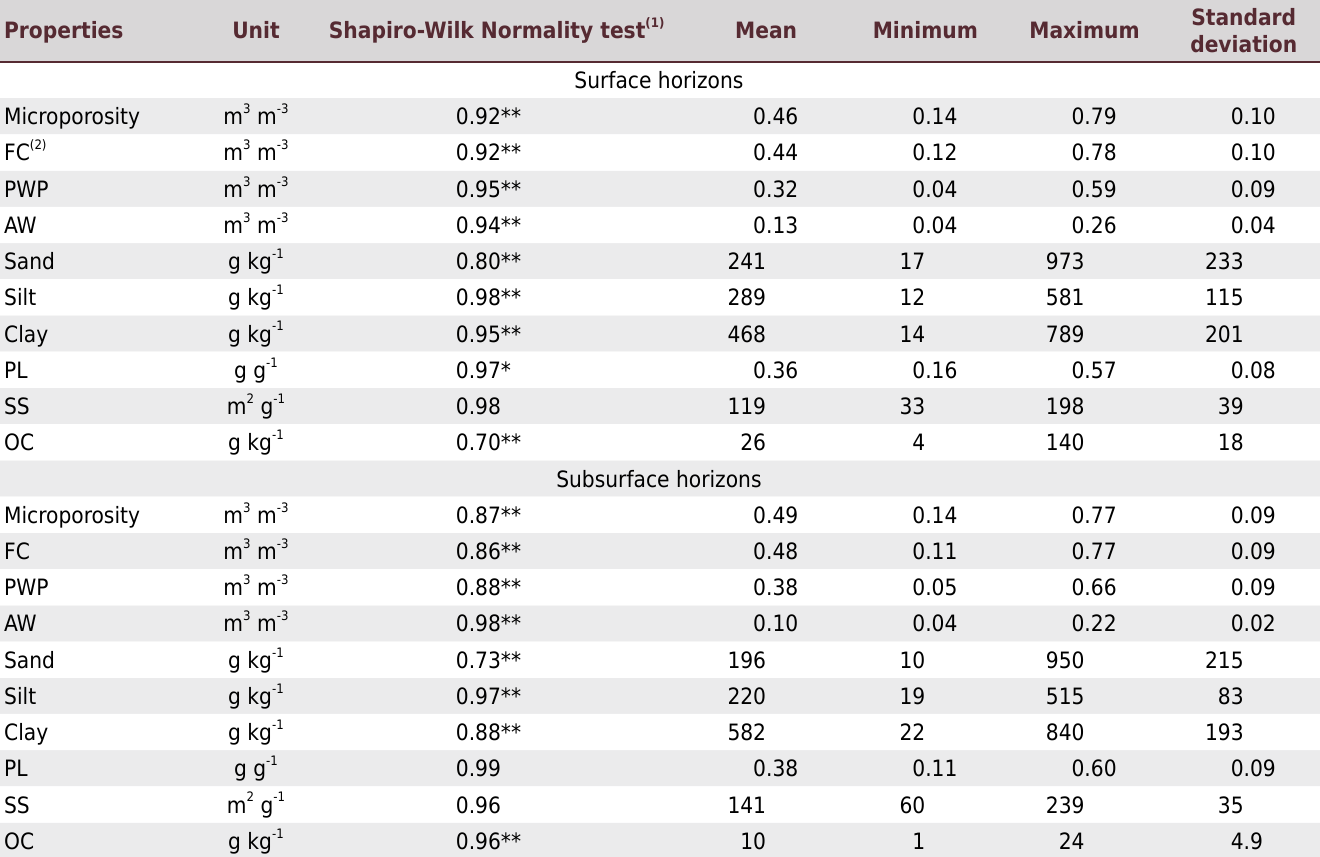
Table 1. Descriptive statistics of soil properties in surface and subsurface horizons of some soil profiles of the state of Santa Catarina, Brazil Properties